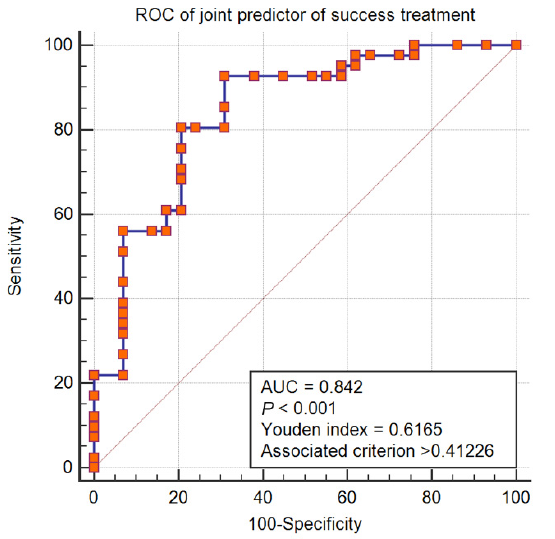
Figure 5. Receiver operating characteristic (ROC) curve of joint predictor of meropenem treatment success.